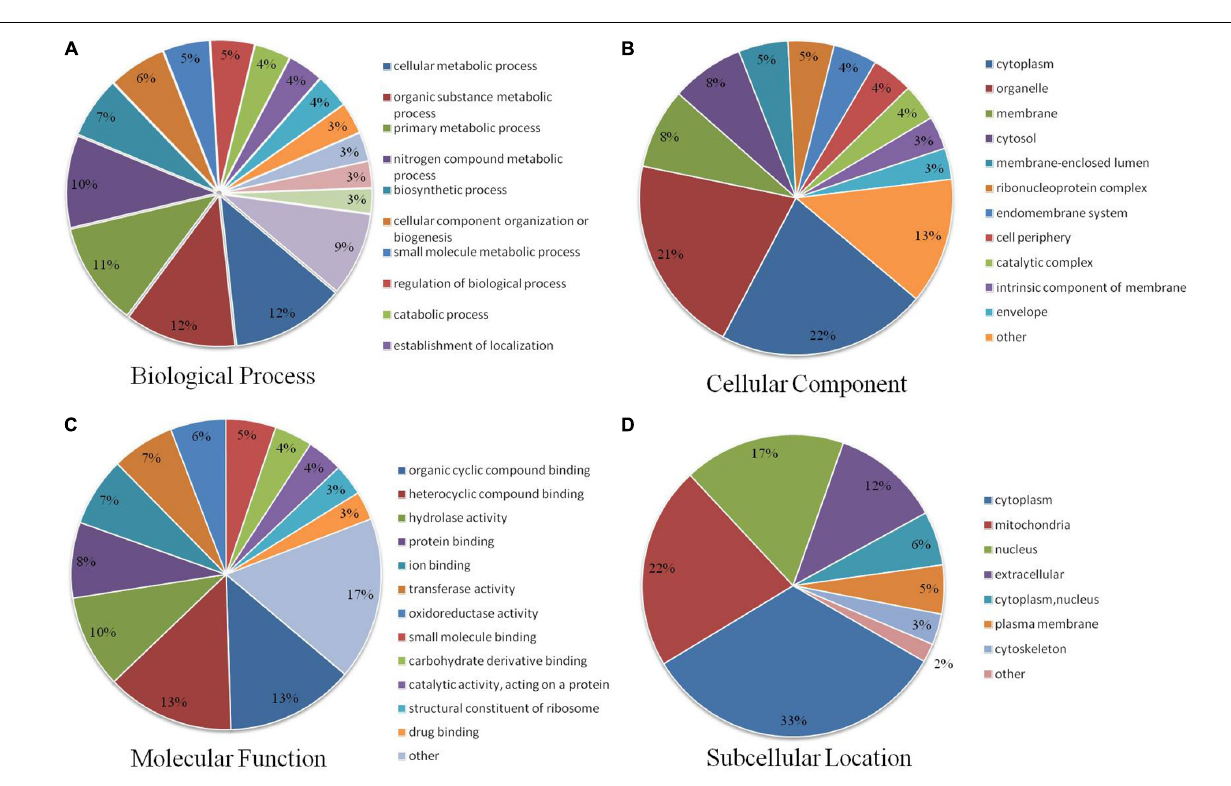
numbers of proteins were enriched in the cytosol and ribosomes ( Figure 4A and Supplementary Table 7 ). According to the molecular function category, the proteins associated with the structural constituents of ribosome, oxidoreductase activity, unfolded protein binding, translation factor activity,